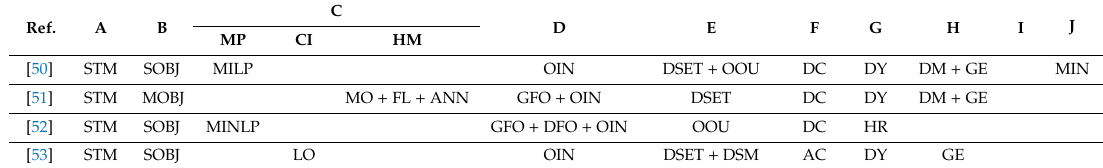
Table 2. Features and attributes of the distinctive papers selected.